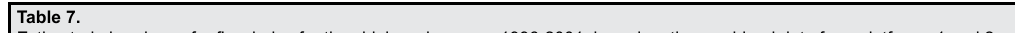
Table 7. Estimated abundance for fin whales for the shipboard surveys 1996-2001, based on the combined data from platforms 1 and 2. Survey esw Sighting rate block (no. per km)